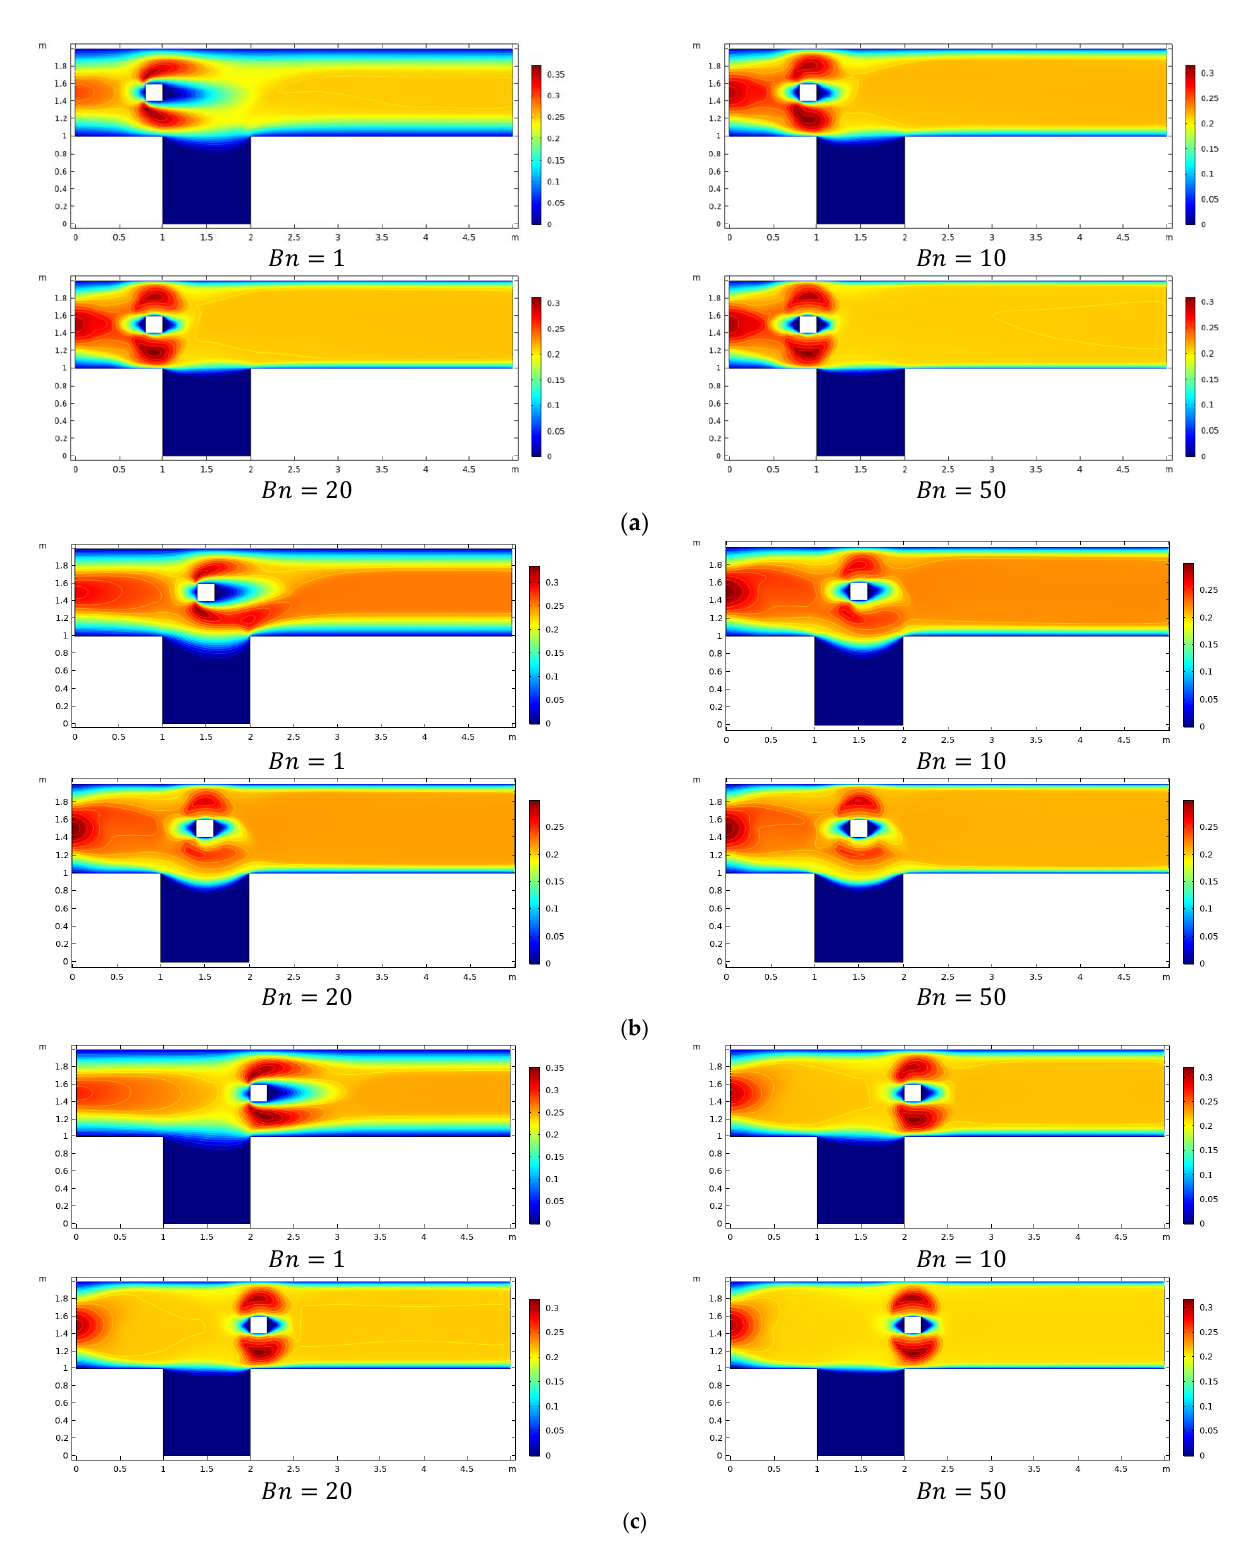
Figure 3. ( a ): Velocity profile with the obstacle center at 𝐶 1 for various 𝐵𝑛. (b ): Velocity profile with the center of obstacle at 𝐶 2 for various 𝐵𝑛 . ( c ): Velocity profile with the center of obstacle at 𝐶 3 for various 𝐵𝑛 .